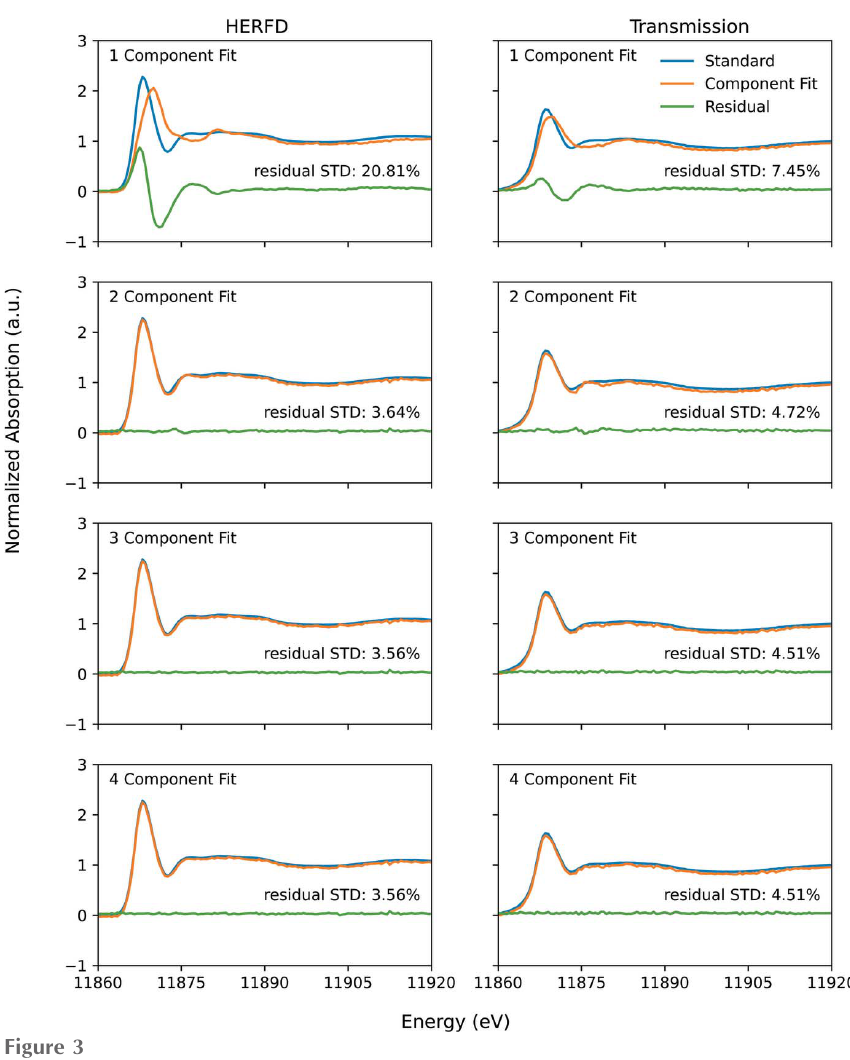
Figure 3 Demonstration of target transformations for HERFD and transmission spectra for the arsenopyrite standard.